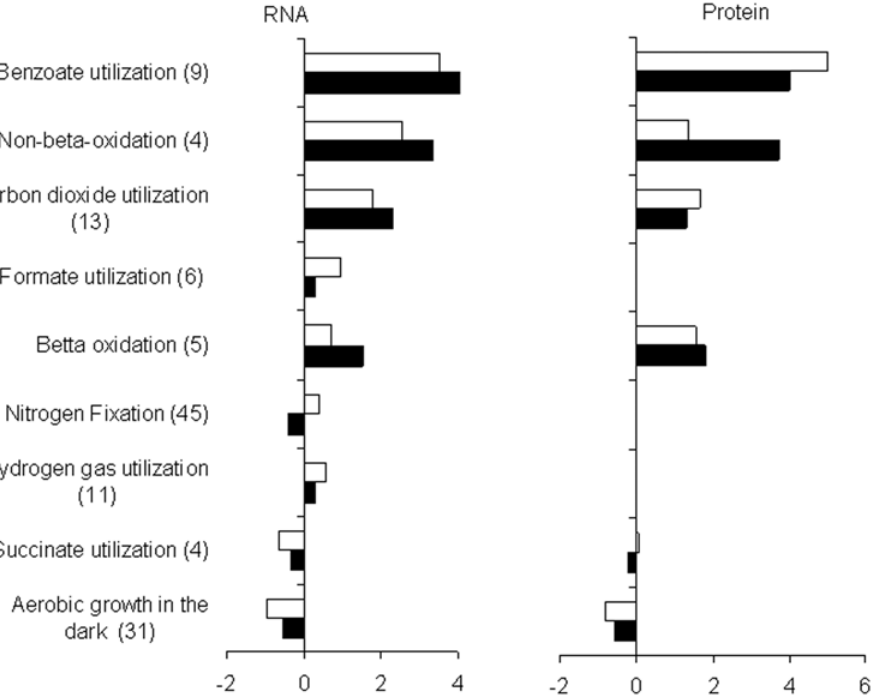
Figure 1. Expression of R. palustris phenotypes under p-coumarate (black columns) and benzoate (white columns) degrading conditions if compared with growth on succinate. The expression is calculated as average log2-ratios of the marker genes representing the phenotype (See Table S1 for the list of genes). The number of marker genes in each cluster is given in parenthesis. Calculated p -values for phenotype expressions and individual expressions of marker genes and proteins are given in the Table S2 and are discussed in the text. Some phenotypes are not revealed at the protein level, because their markers genes are represented by membrane proteins, like hydrogenase, nitrogenase, or formate hydrogenlyase. Detection of membrane proteins by LC-MS/MC is more difficult [41–43].